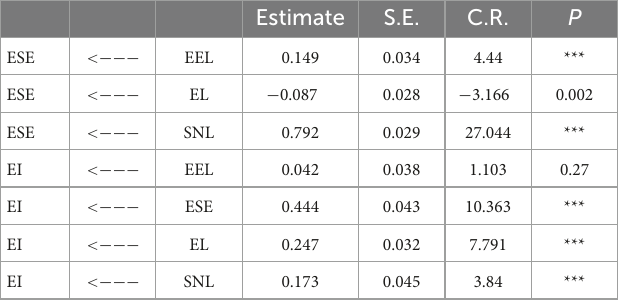
TABLE 4 Estimation of regression coefficient and parameter.